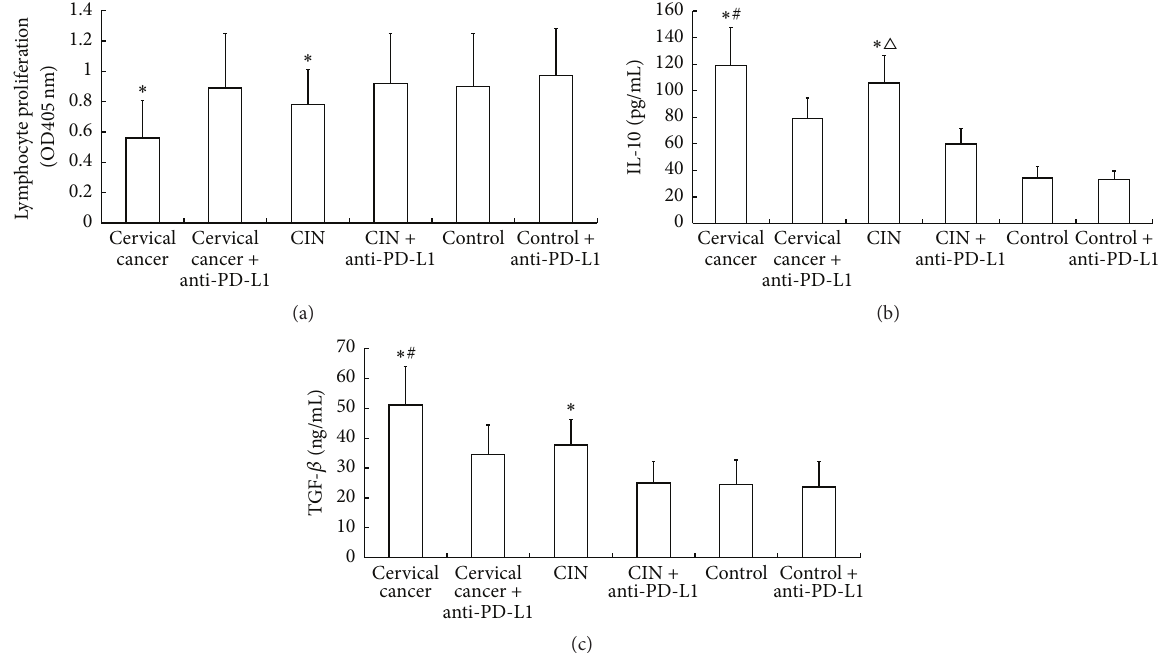
Figure 6: Effect of PD-L1 on lymphocyte proliferation and the secretion of IL-10 and TGF- 𝛽 . Anti-PD-L1 antibody was used to block PD-L1. (a) Lymphocyte proliferation determined using MTT assay. Concentrations of (b) IL-10 and (c) TGF- 𝛽 of culture supernatants measured using CBA assay. ∗ 𝑃 < 0.05 compared with control group; # 𝑃 < 0.05 compared with cervical cancer + anti PD-L1 group; △ 𝑃 < 0.05 compared with CIN + anti-PD-L1